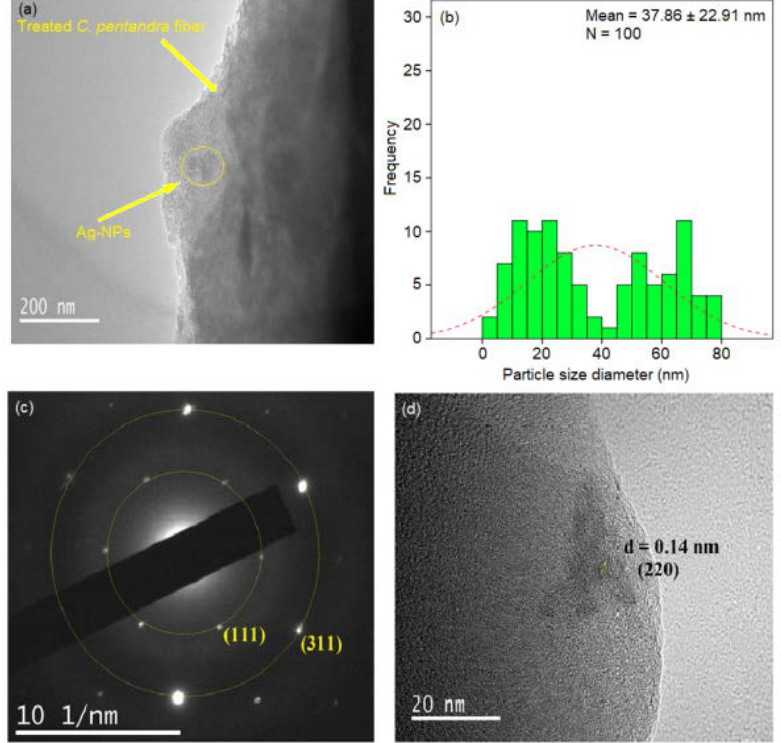
Figure 9. ( a ) Field Emission Transmission Electron Microscope (FETEM) image ( b ) particle size distribution histogram ( c ) SAED pattern and ( d ) lattice d-spacing parameter of C. pentandra /AgNO 3 .